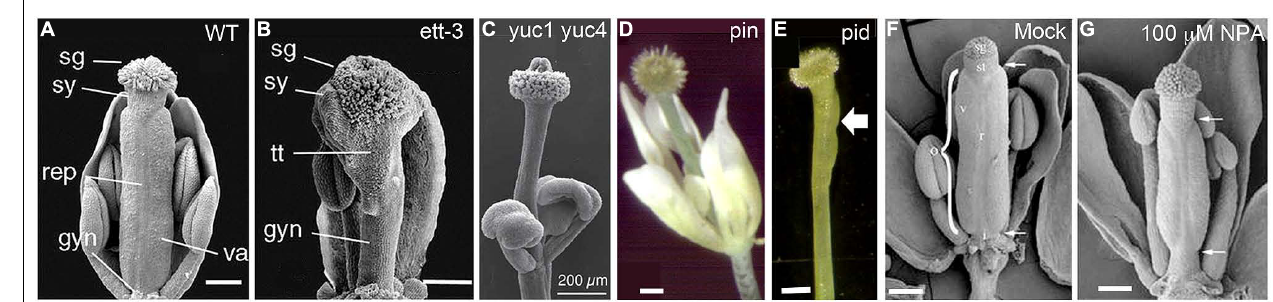
FIGURE 2 | Gynoecium phenotypes of mutants defective in auxin biosynthesis, transport, or signaling. (A) Wild-type gynoecium at stage 12 with the parts labeled as stigma (sg), style (sy), replum (rep), valves (va), and gynophore (gyn). (B) ett-3 gynoecium at stage 12, showing an elongated gynophore, a diminished valve pushed toward the apex, and expanded stigma, style, and transmitting track (tt) tissue. (C) Gynoecium of a yuc1-1 yuc4-1 double mutant, showing the complete absence of ovary valve and an enlarged apical stigma. (D) A weak pin mutant showing a gynoecium without any ovary valve tissue. (E) A pid gynoecium with one